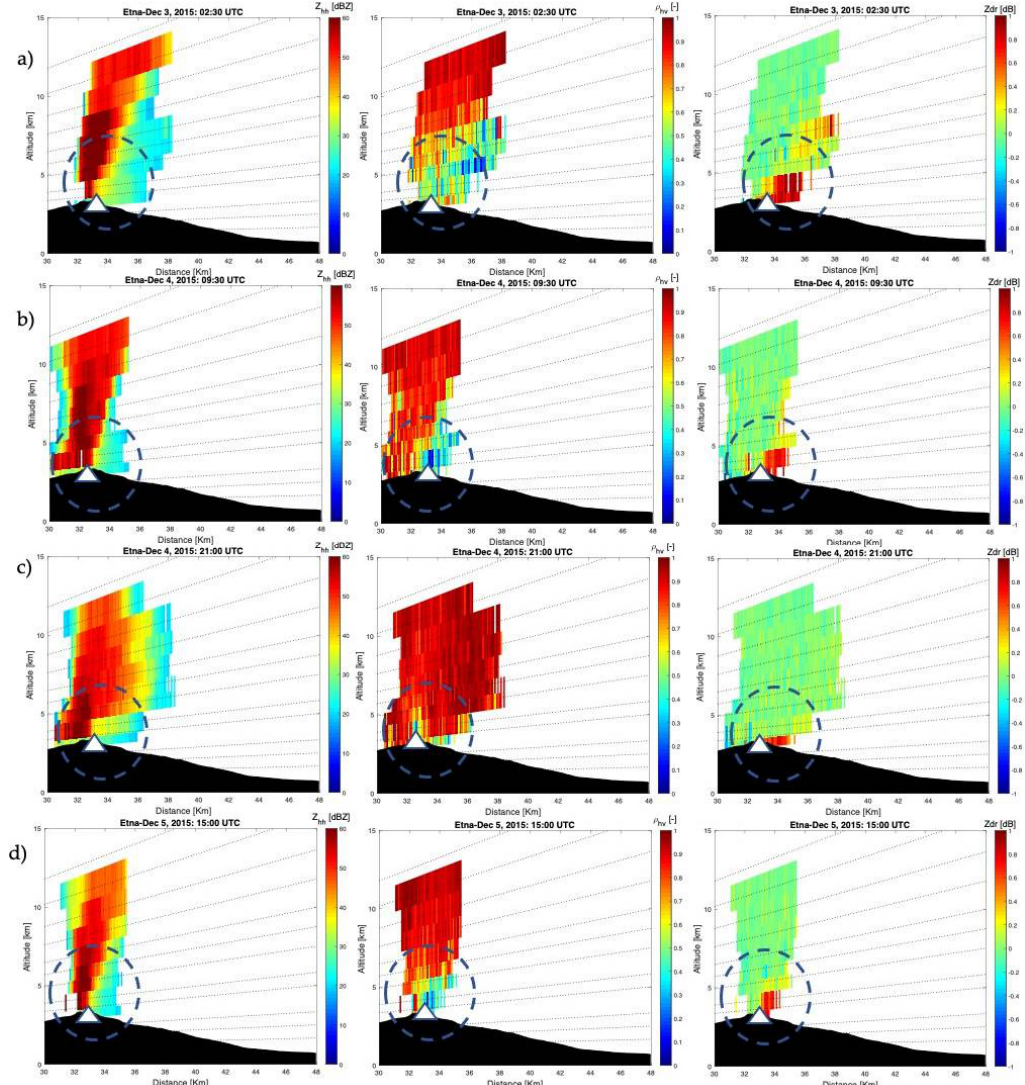
Figure 6. X-Band radar retrievals of Etna explosive activity on 3 December 2015 at 02:30 UTC ( a ), on 4 December 2015 at 09:30 UTC ( b ), 4 December 2015 at 21:00 UTC and ( c ) on 5 December 2015 at 15:00 UTC ( d ). Range-Height Indicator (RHI) of the reflectivity factor Z hh (dBZ), copolar correlation coe ffi cient ρ hv (admin) and Z dr (dB) of X-band radar along the radar azimuth intercepting the vent. The white triangle identifies the position of the NSEC and VOR